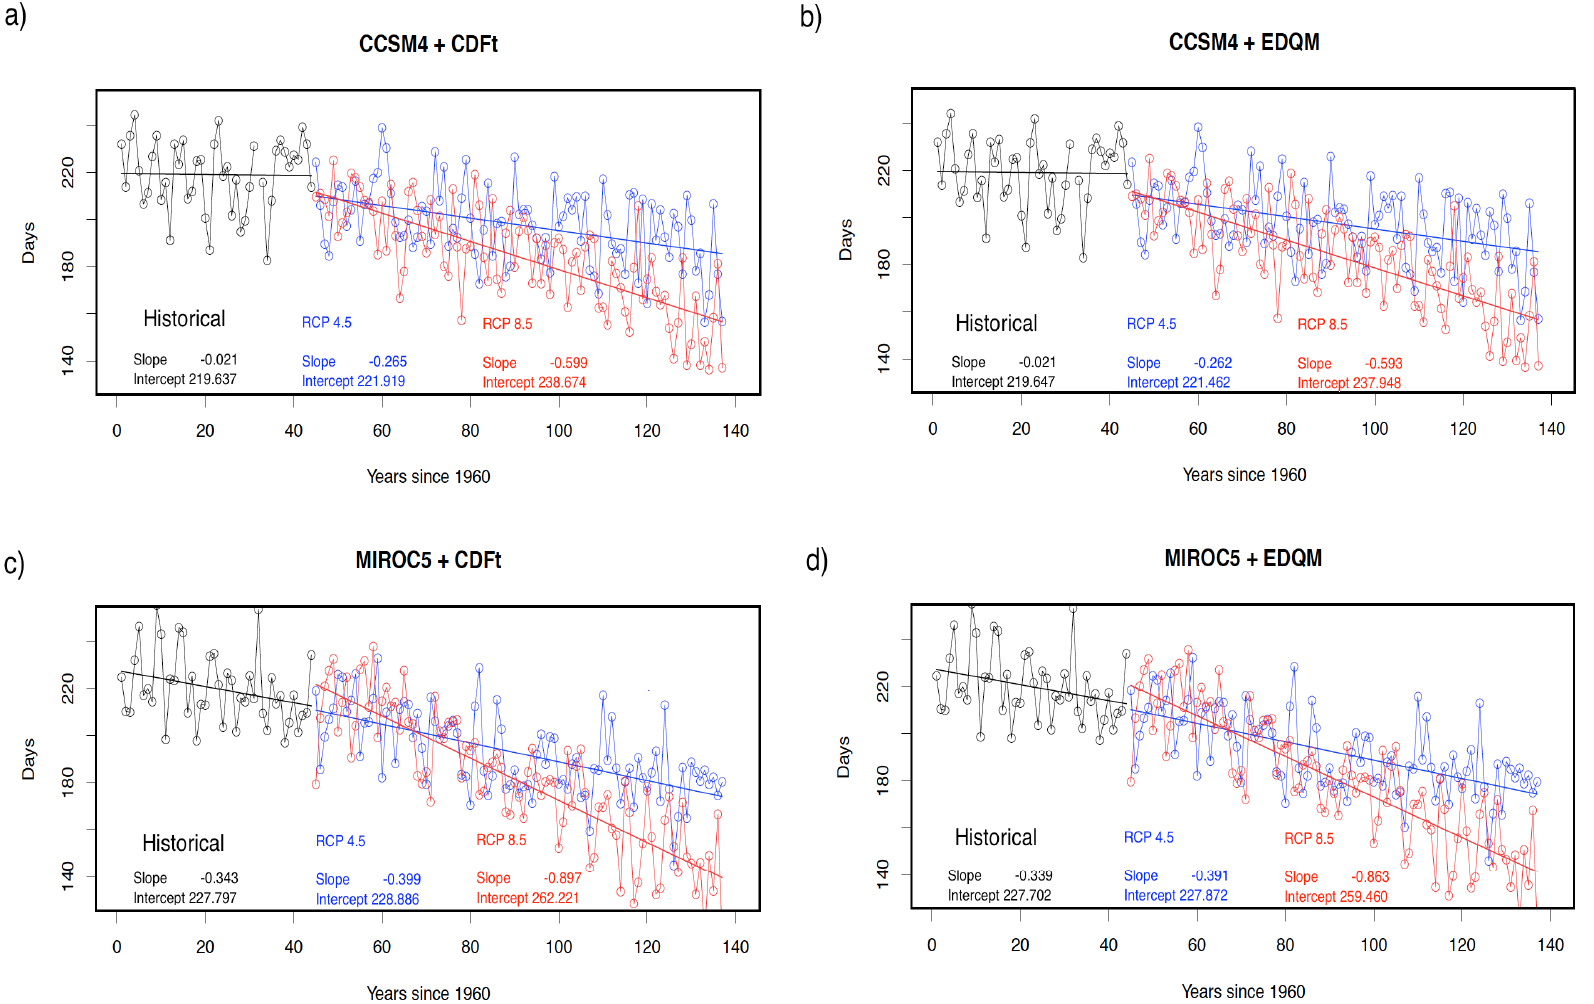
Figure 10. Number of days needed to reach 1825 GDD over the study period (1960–2099).